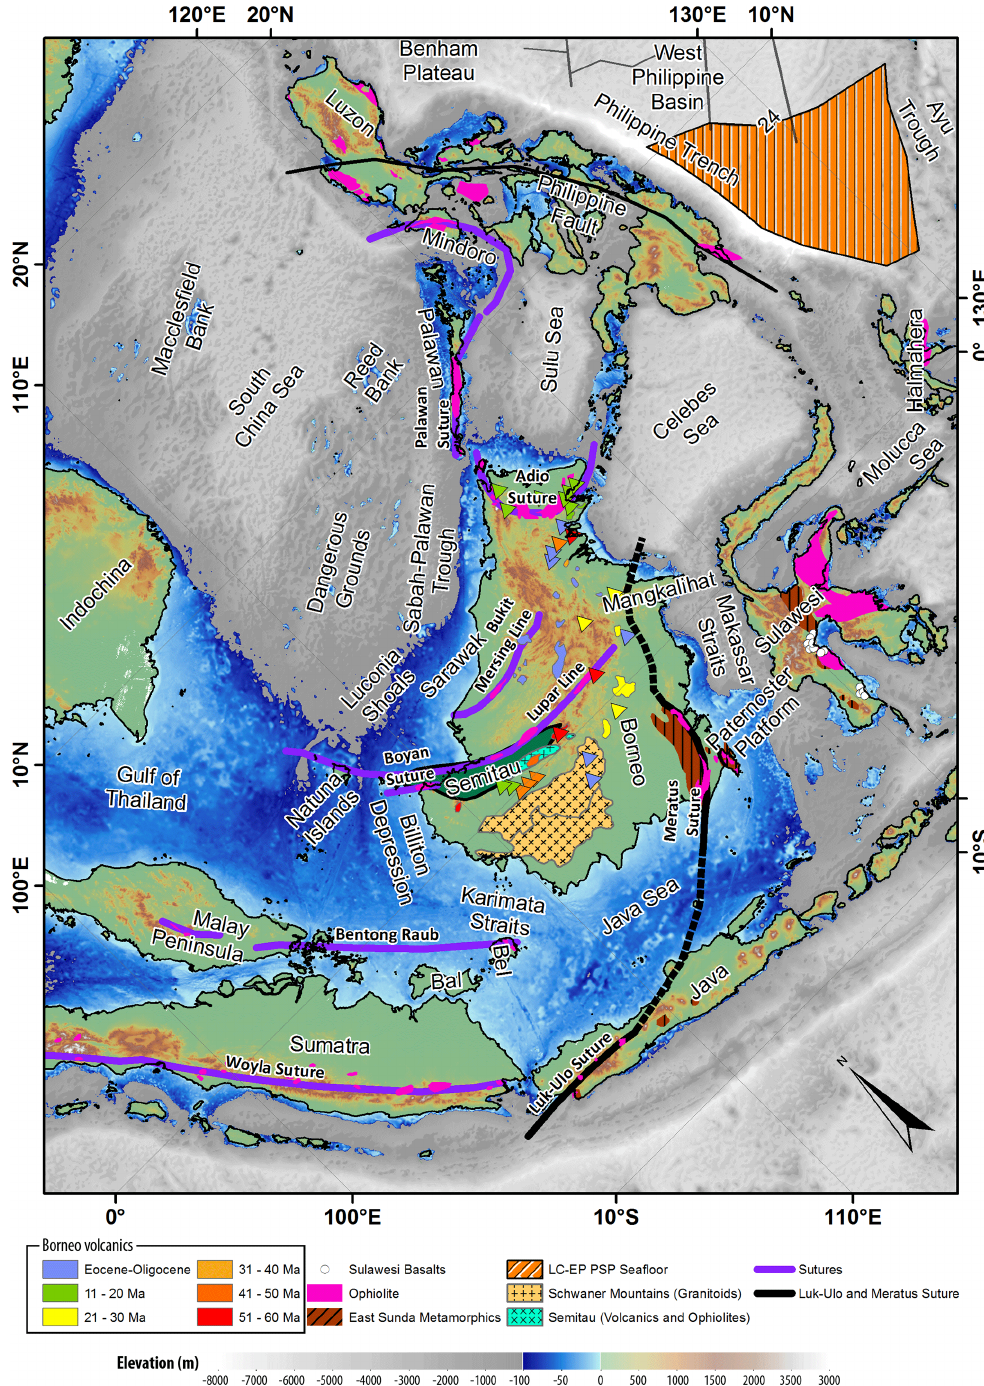
Fig. 2. Sundaland suture distributions with the Cretaceous-age Luk-Ulo and Meratus sutures resulting from the accretion of East Java, easternmost Borneo, Mangkalihat and West Sulawesi. The Billiton Depression has been previously invoked as a Cretaceous suture resulting from the docking of southwest Borneo with Sundaland. However, little evidence has been presented to indicate that this is a (Cretaceous- age) suture. We interpret the Schwaner granitoids to be continuous with the Natuna Arc and the Fukien–Reinan Massif (see Fig. 6) as an Andean-style subduction zone along east Asia in the Cretaceous. The Boyan Suture and Lupar Line bound the Semitau block (dark green) that accreted to northern Borneo in the mid-Eocene to result in the Sarawak Orogeny. LC-EP PSP–Late Cretaceous(?)–early Paleogene Philippine Sea plate seafloor crust. Eocene to Holocene volcanics on Borneo are age-coded from Soeria-Atmadja et al. (1999).